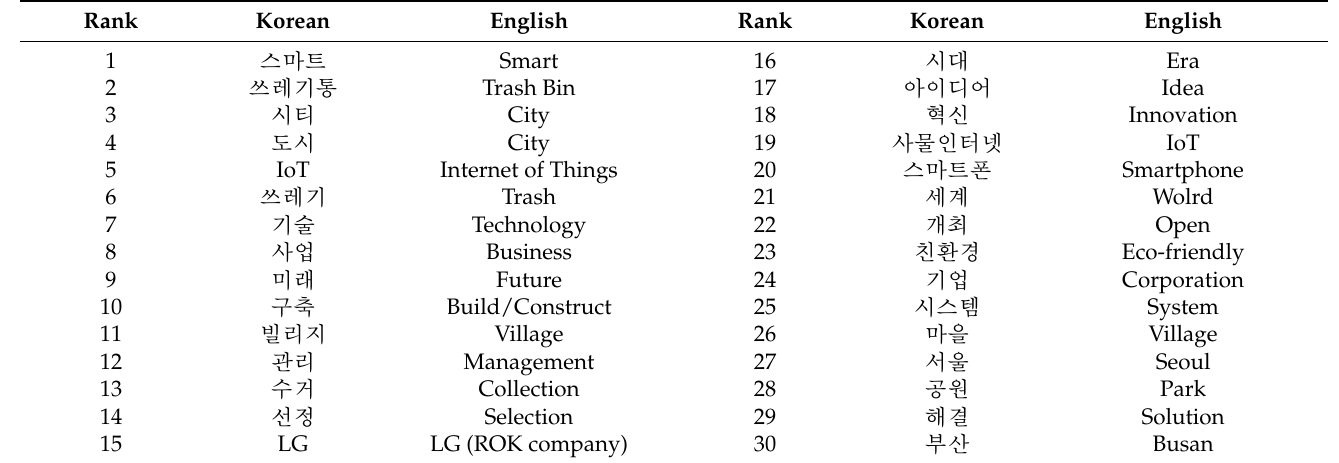
Table A1. Translation of WordCloud Top 30 Table A1 . Translation of WordCloud Top 30 Words.